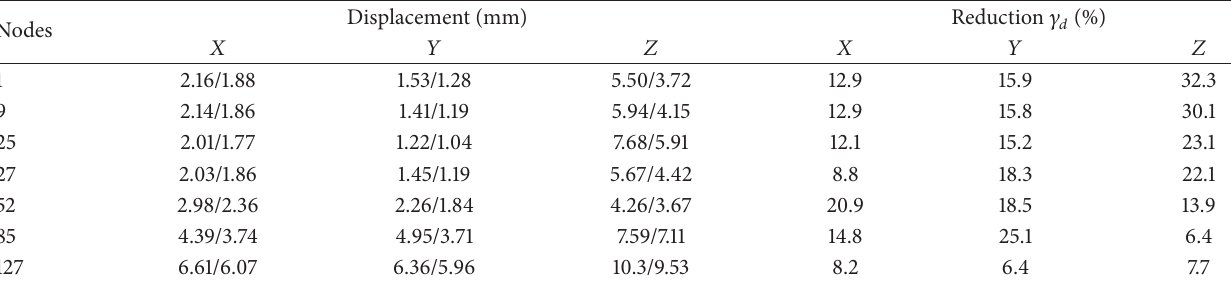
Table 4: Maximum displacement response and reduction of typical